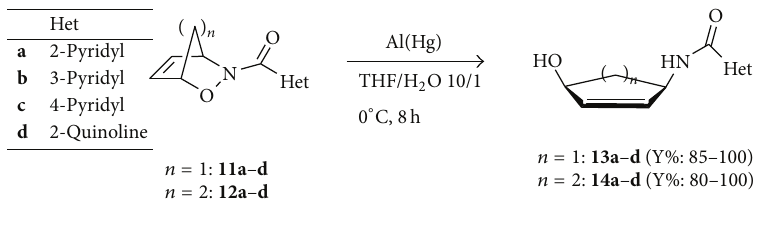
Scheme 4: Reductive cleavage of N–O bonds and synthesis of the 4-hydroxycyclopent-2-enyl heterocyclic amides 13a – d and 14a – d